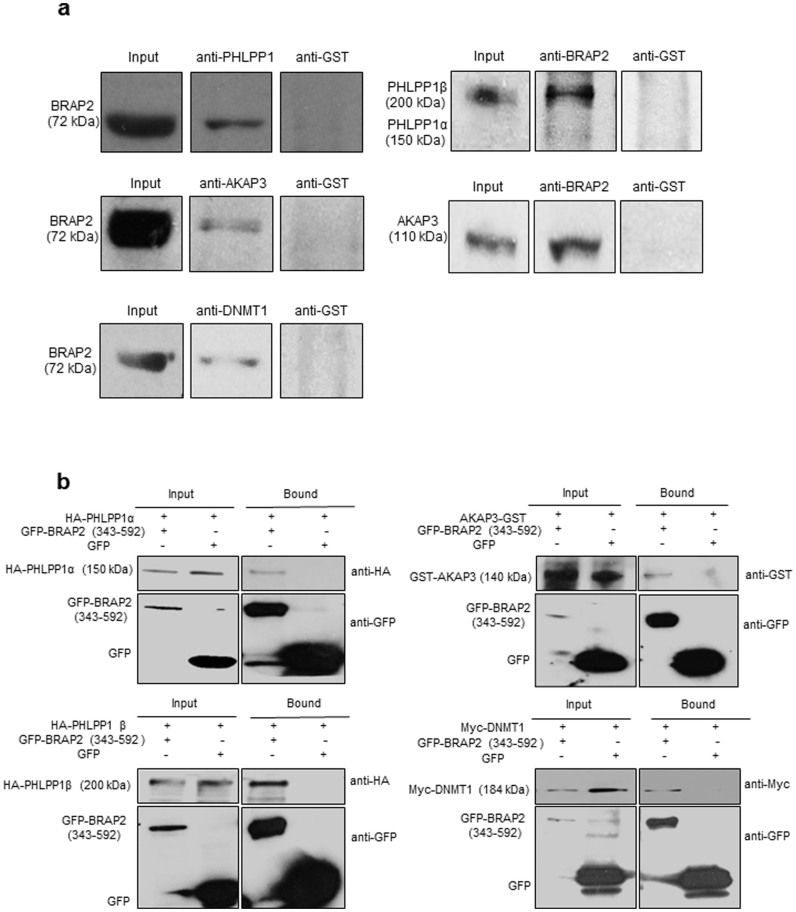
BRAP2 interacts with PHLPP1, AKAP3 and DNMT1 in mouse testis.(a) Coimmunoprecipitation (IP) experiments were performed as described in methods from adult mouse testis lysate using anti-PHLPP1, AKAP3, DNMT1 or GST antibodies and subjected to Western analysis using anti-BRAP2 (left) where as anti-BRAP2 antibody was used for IP from the same lysates and subjected to Western analysis using anti-PHLPP1, AKAP3 or anti-GST antibody (right) (b) GFP pull downs were performed from Hek293T cells co-transfected to express either GFP-BRAP2 (343-592), or GFP and HA-PHLPP1 α, or HA-PHLPP1 β or GST-AKAP3 or Myc-DNMT1 prior to Western analysis of GFP-trap-precipitated (bound) fractions using specific antibodies to GFP.